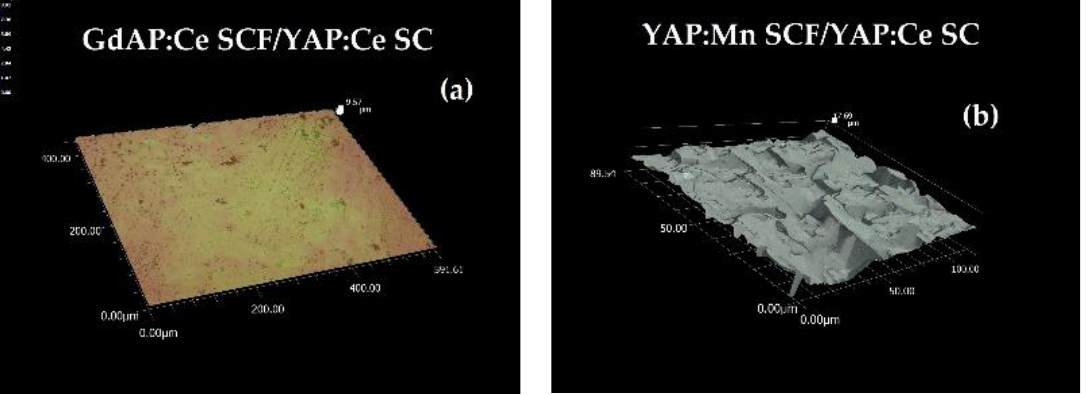
Figure 3. Surface morphology of GdAP:Ce SCF/YAP:Ce SC ( a ) and YAP:Mn SCF/YAP:Ce ( b ) epitaxial structures.